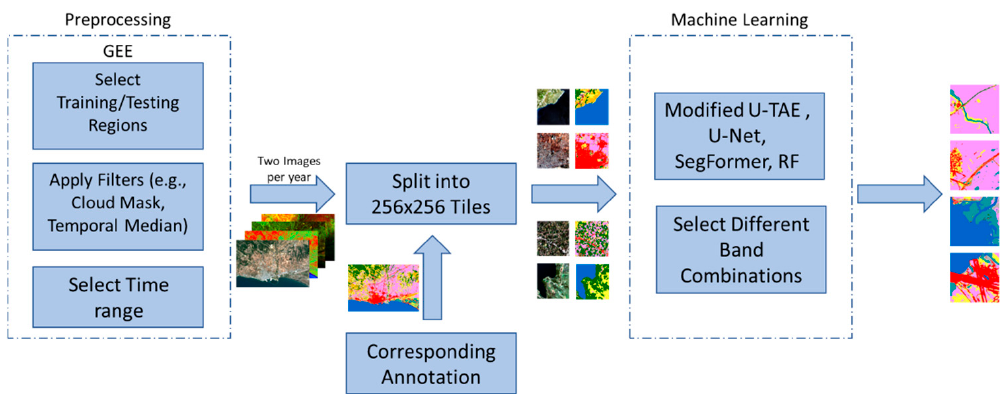
Figure 1. Flowchart of the proposed land cover classi fi cation approach.